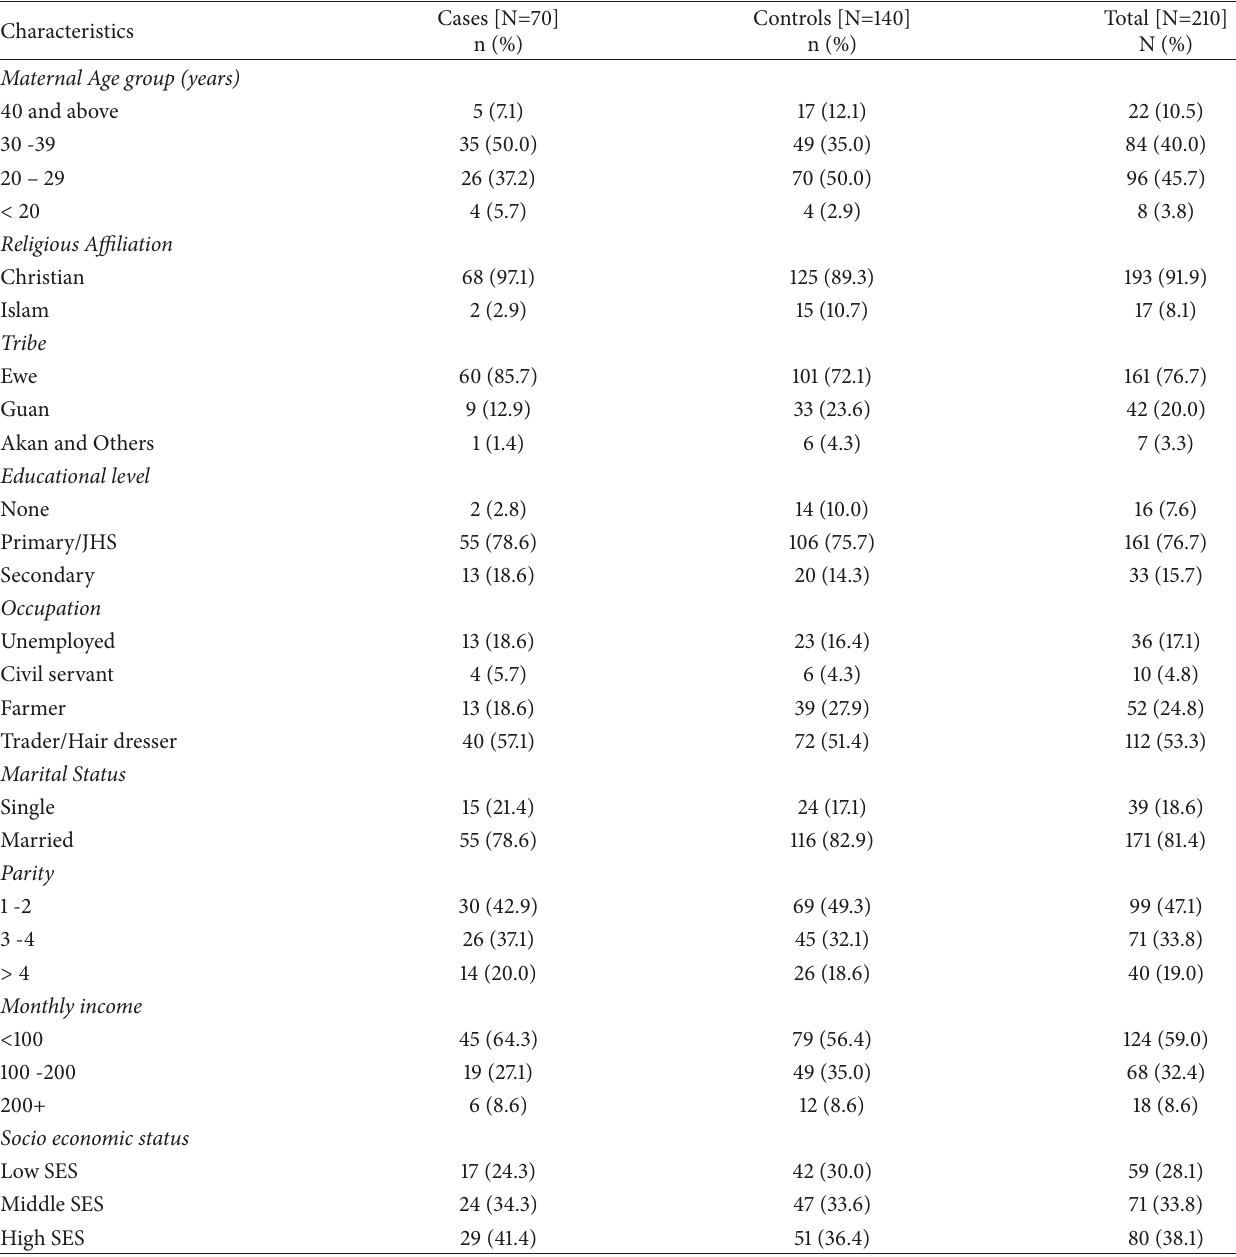
Table 2: Socio demographic characteristics of